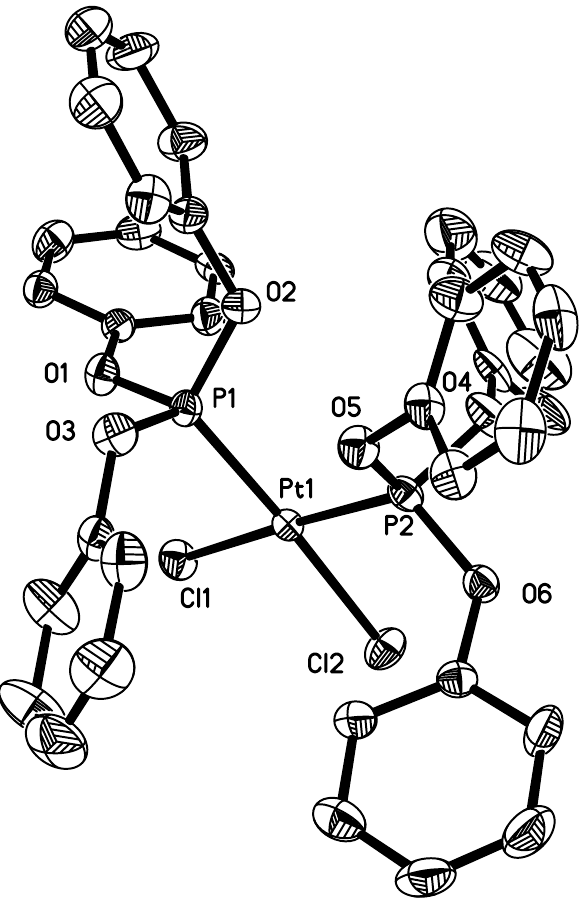
(P(OPh) ) ] showing the atom numbering scheme 2 3 2